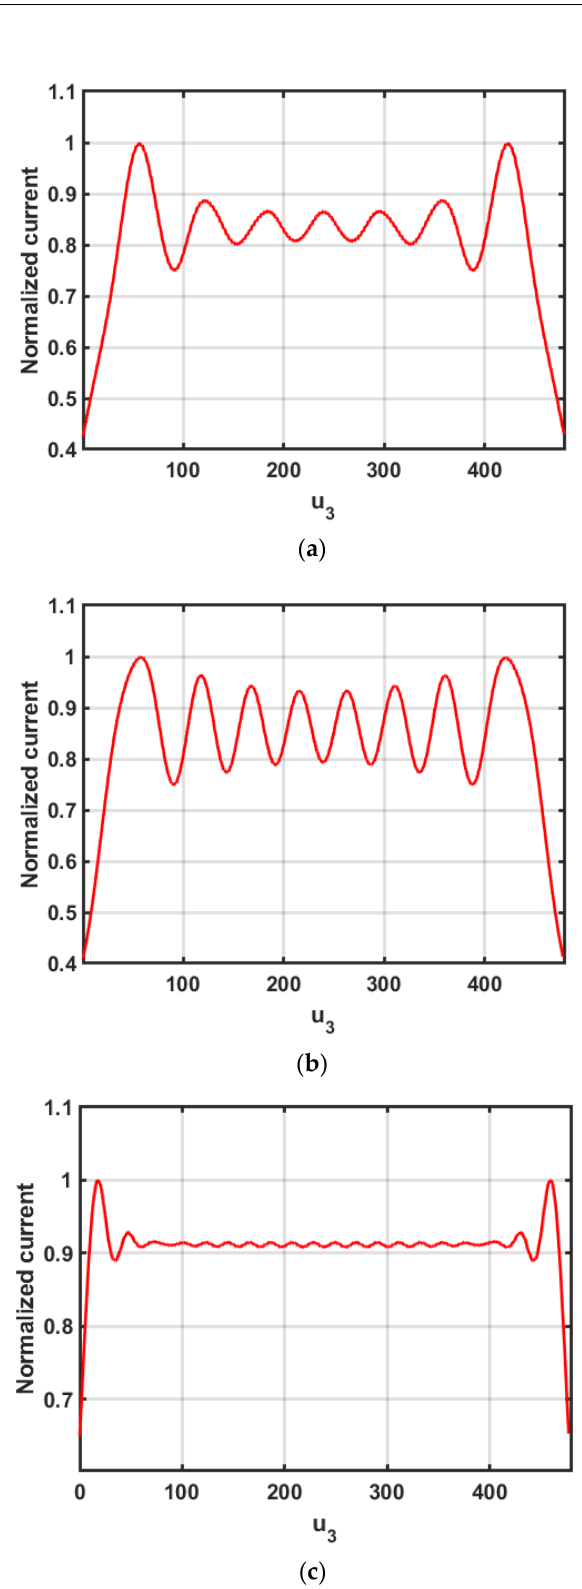
Figure 14. Induced current in discretized points of helix by near tangential electric field. ( a ) n = 20 antennas. ( b ) n = 21 antennas. ( c ) n = 48 antennas.